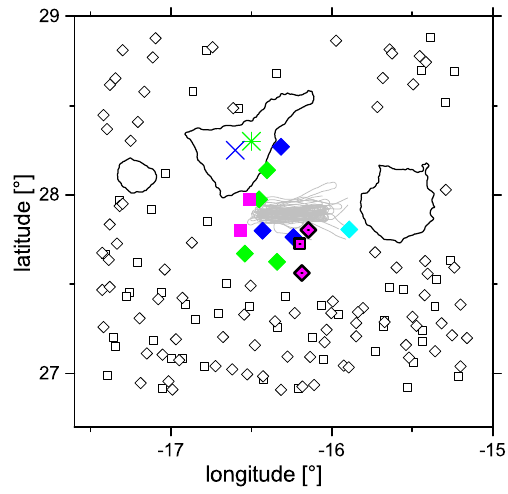
Figure 5. Site map indicating the location of the different instru- ments and ground pixels during the aircraft campaign on 6 days in July 2013. Green star: Izaña observatory (location of the first Pi- carro and the FTIR); blue star: Teide observatory (location of the second Picarro); grey lines: aircraft flight track during ISOWAT measurements; black squares and diamonds: cloud-free ground pix- els of IASI-A and -B, respectively, during the six aircraft flights; coloured filled squares and diamonds: pixels that fulfil our coinci- dence criteria for IASI-A and -B, respectively (the colours mark the different days in analogy to Fig.